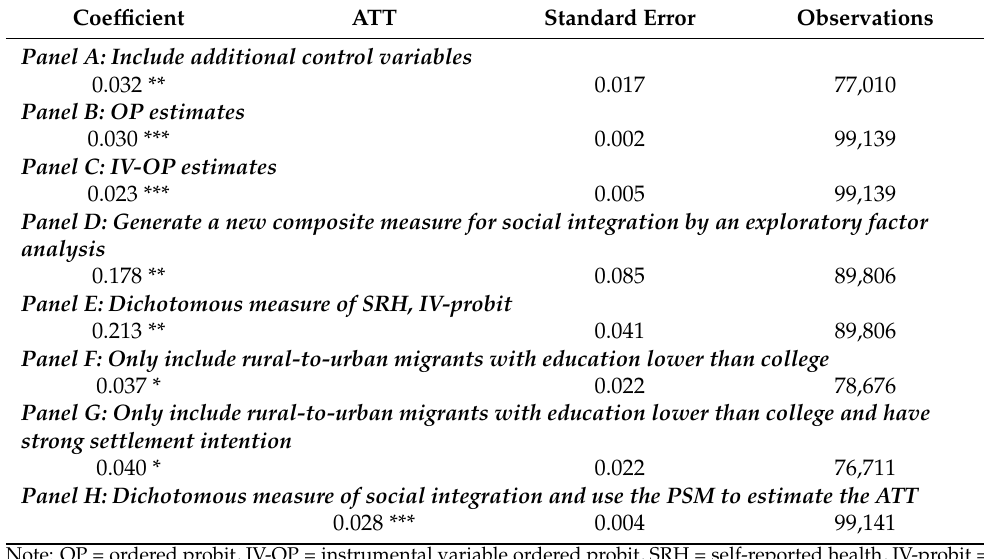
Table 4. Robustness checks: alternative specifications.